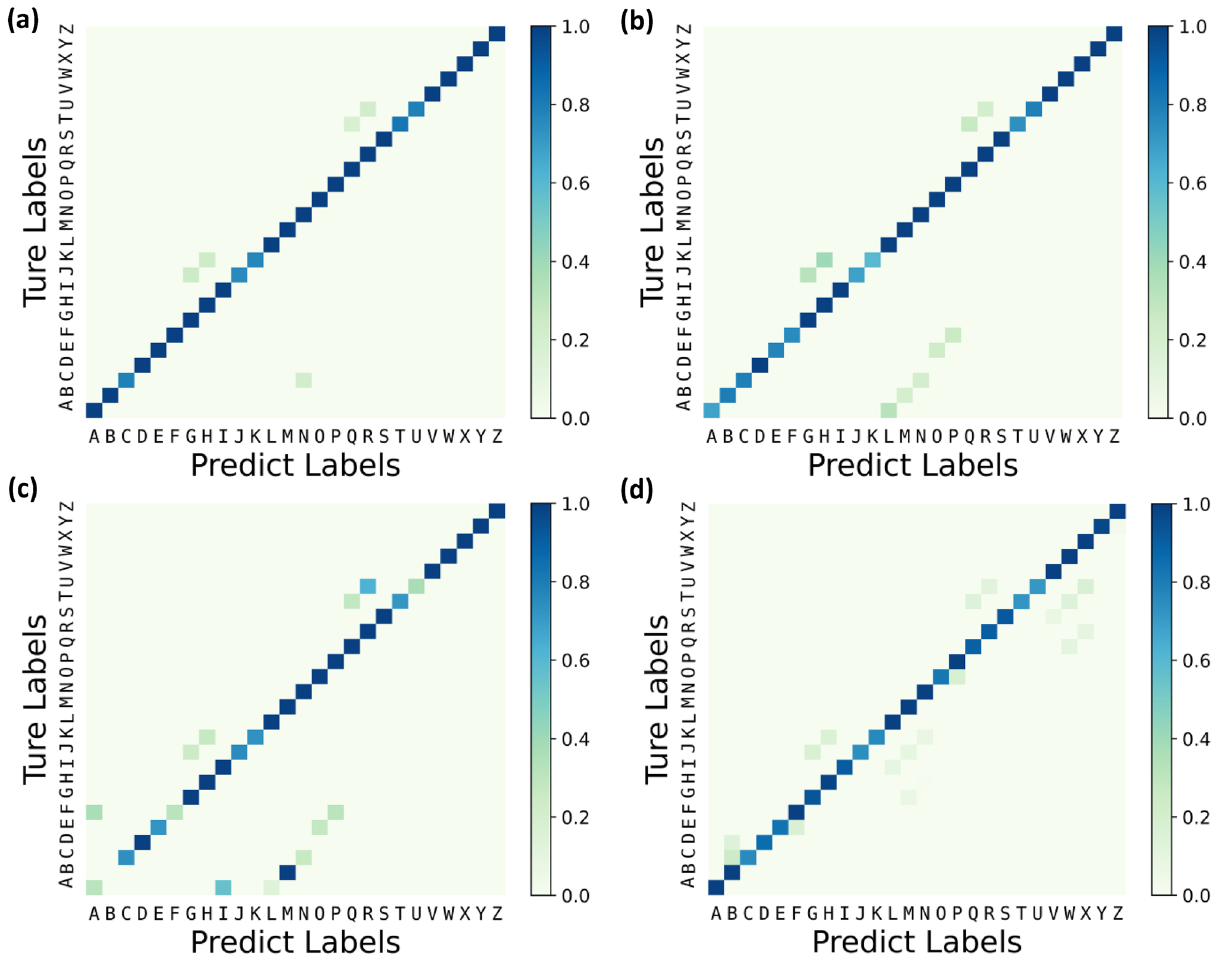
Figure 8. Confusion Matrix of the 26-alphabets recognition by the E-skin system for various scenarios: ( a ) without weight noise, ( b ) with ± 10% weight noise, ( c ) with ± 20% weight noise, and ( d ) measurement result.